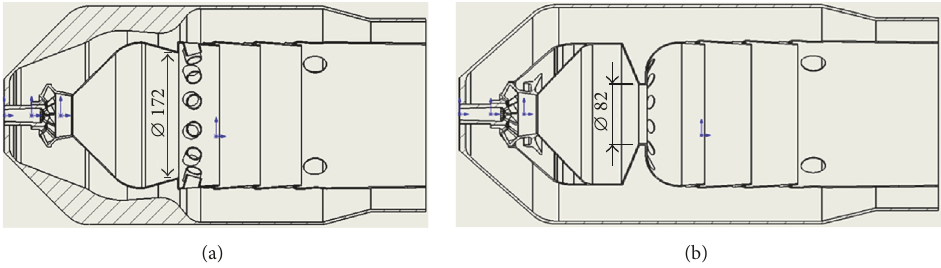
Figure 13: Structure designs of combustors: (a) modified design 1; (b) modified design 2.